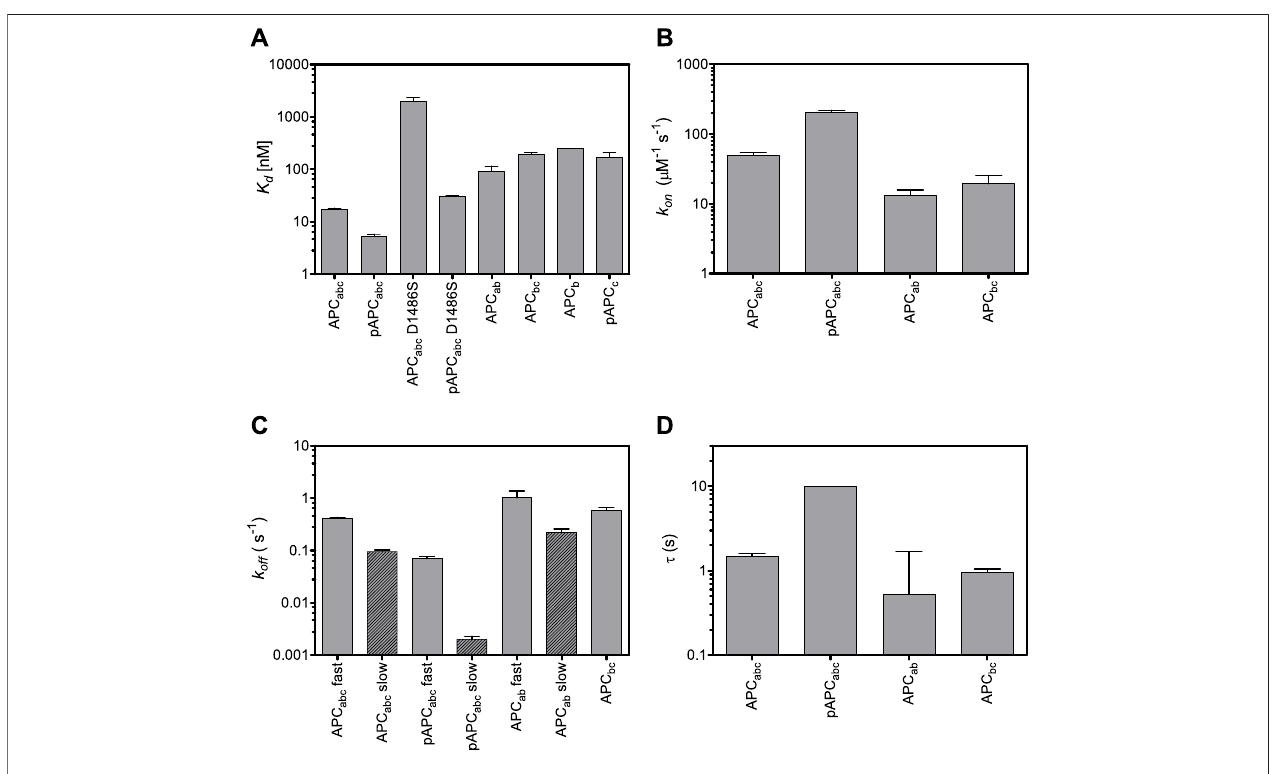
FIGURE 4 | Effectsof truncations and mutations in APC on β -catenin-binding. Dissociation constants (A) , on-rates (B) , off-rates (C) , and time constants (D) . Both fast and slow off-rates are shown. The time constant are calculated from the fast off-rates.